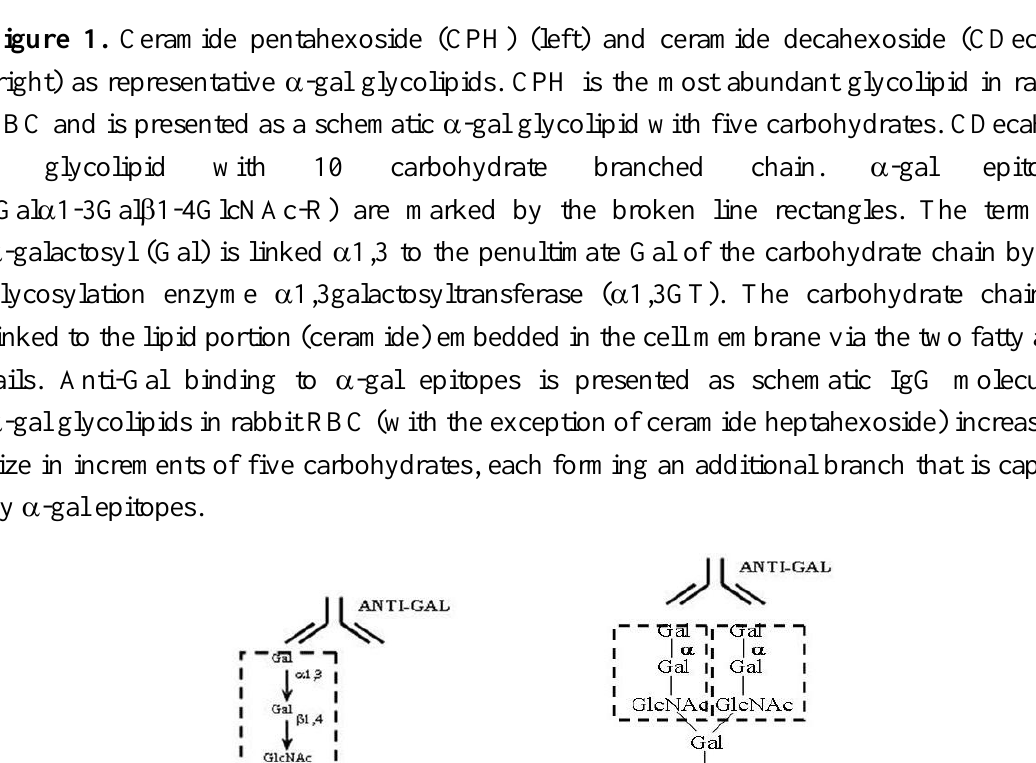
Figure 1. Ceramide pentahexoside (CPH) (left) and ceramide decahexoside (CDecaH)